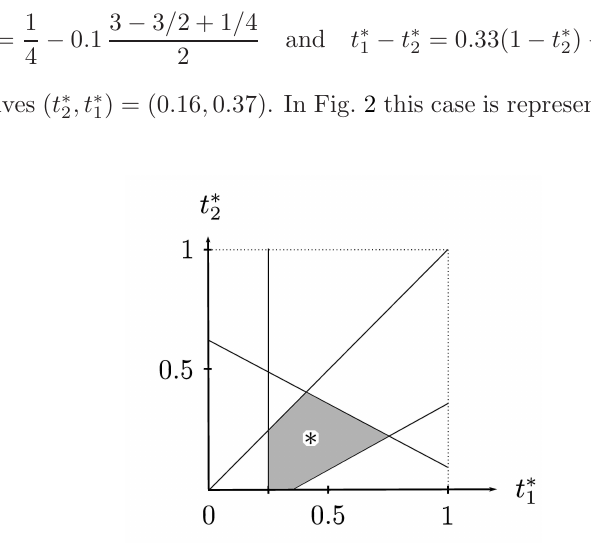
Figure 2. Graphical representation of the set of legal equilibria ( t ∗ 2 ,t ∗ 1 ) of the inspector (shaded area) according to (2.8), i.e., equilibria in which the operator’s equilibrium strategy is legal behavior. In the midst of this set the star indicates the equilibrium of the inspector according to (2.4).